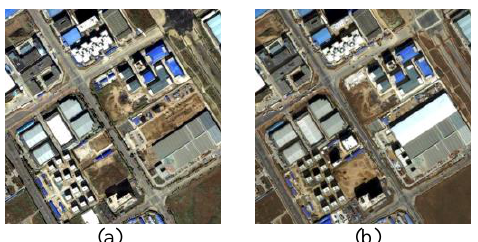
Figure 3. Experimental images. (a) image in 2009 (b) image in